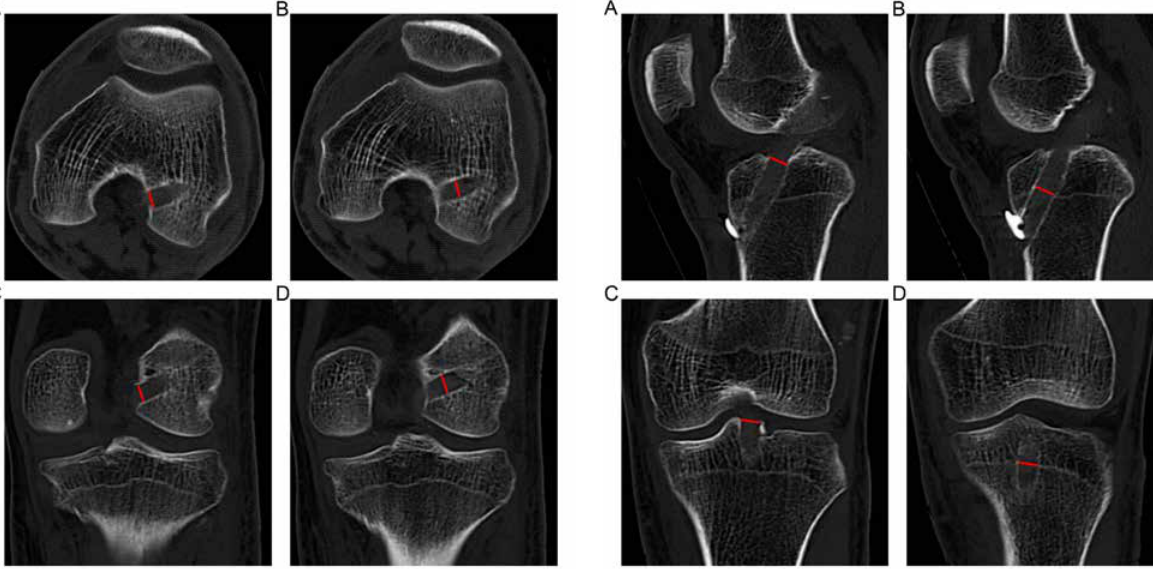
Figure 3: The measurement of the femoral tunnel diameter. (A): Notch on the axial section (FA 1); (B): Middle on the axial section (FA 2); (C): Notch on the coronal section (FC 1); (D): Middle on the coronal section (FC 2).